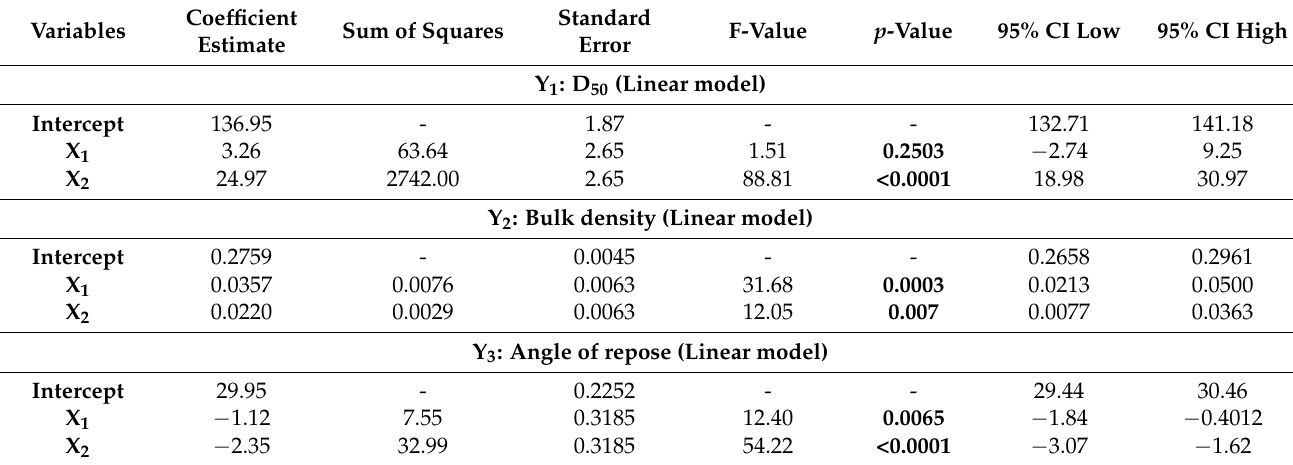
Table 6. ANOVA analysis of granules measured